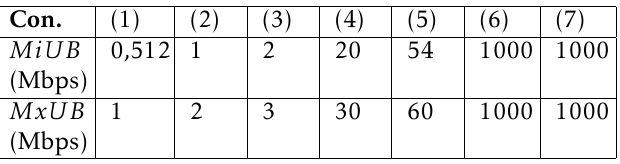
Table 3. Bandwidth allotted to each link